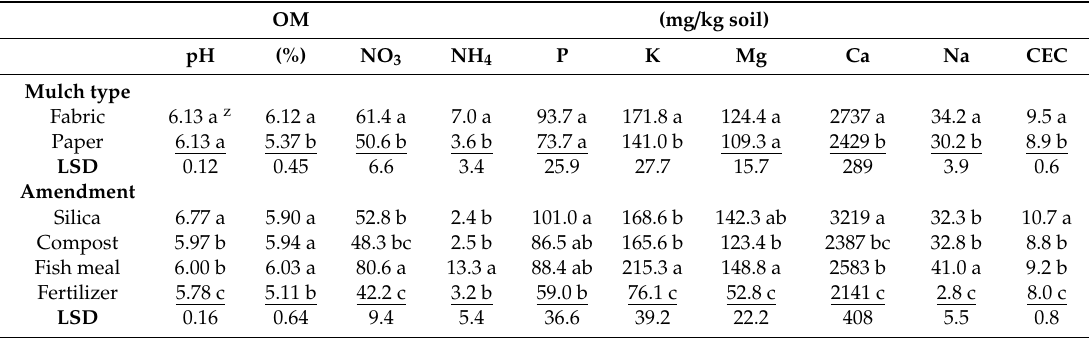
z Values within columns followed by the same letter for each parameter are not significantly di ff erent from each other based on ANOVA and Fisher’s protected LSD test ( p < 0.05). Interaction between mulch type and soil amendment factors was not significant for any property ( p >